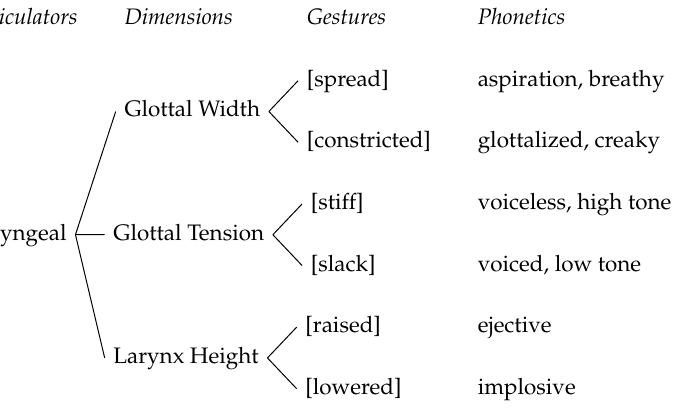
Figure 1. Laryngeal dimensions, completions, and phonetics (adapted from (Avery and Idsardi 2001, p. 42; Purnell and Raimy 2015, p.